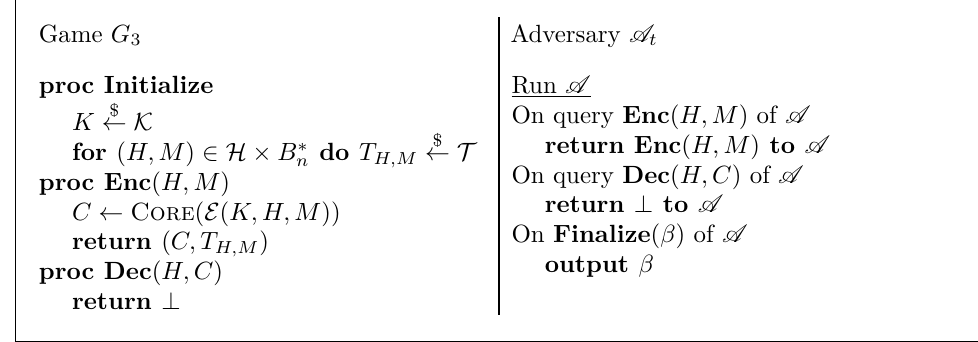
Figure 12: Adversary A c for the proof of Lemma 2.